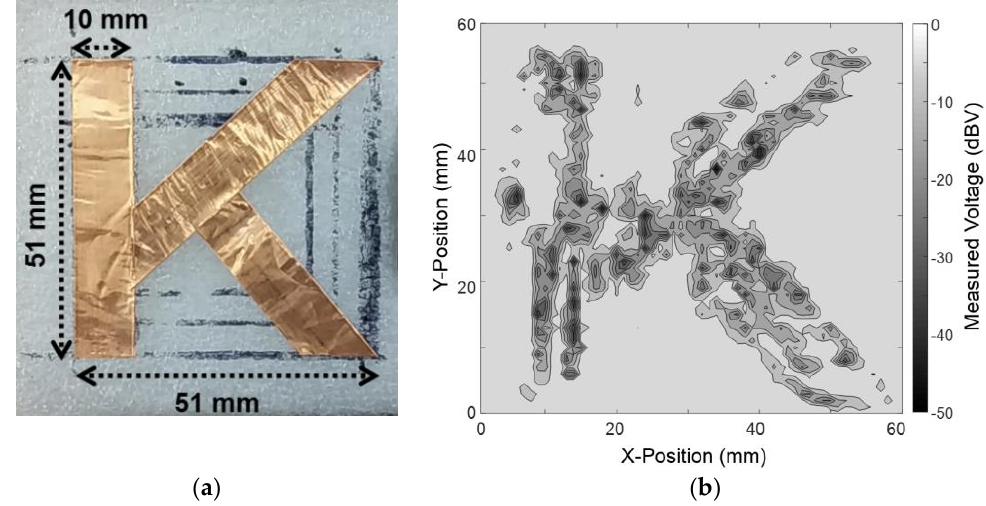
Figure 11. ( a ) A photograph of the moving sample with a ‘K’ shape and size of 51 mm × 51 mm; ( b ) measured THz image for the sample.